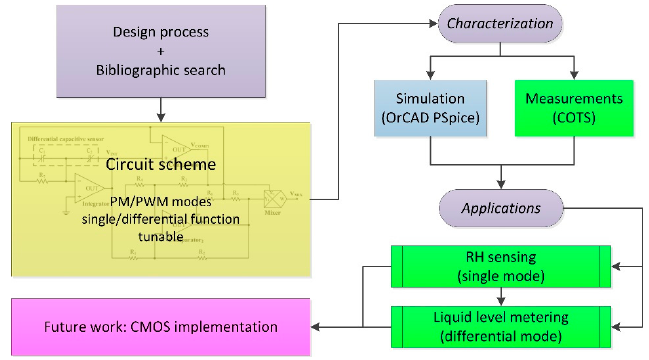
Figure 1. Block diagram of the conducted